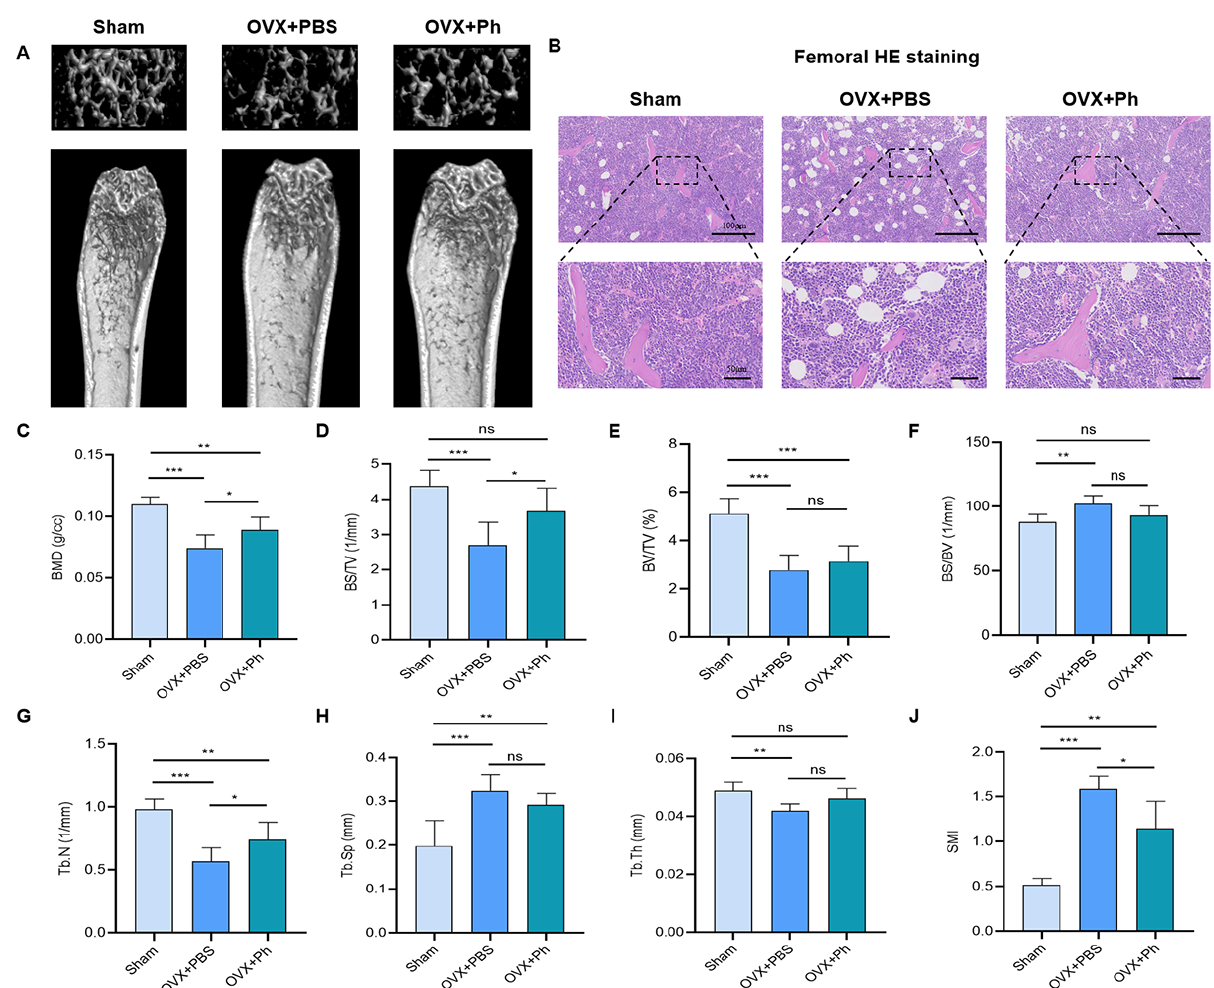
Figure 2. The perfusion of Ph mitigated the bone loss in mice with OVX-mediated OP. A morphometric analysis was conducted on the 50 cross-sections (0.5mm) of ROI under femoral growth plate, and a further analysis was performed on 200 cross-sections of the trabecular bone with a height of 2 mm. ( A ) The Micro-CT scanning results of the distal femur of the mice in different group; ( B ) The femoral H&E staining results of the distal femur of the mice in different group. The scale bars represented as 100 µ m and 50 µ m; ( C ) BMD; ( D ) BS/TV; ( E ) BV/TV; ( F ) BS/BV; ( G ) Tb.N; ( H ) Tb.Sp; ( I ) Tb.Th; ( J ) SMI of femoral trabecular bone were analyzed by Micro-CT. * p < 0.05, ** p < 0.01, and *** p < 0.001 compared with comparable group; ns no